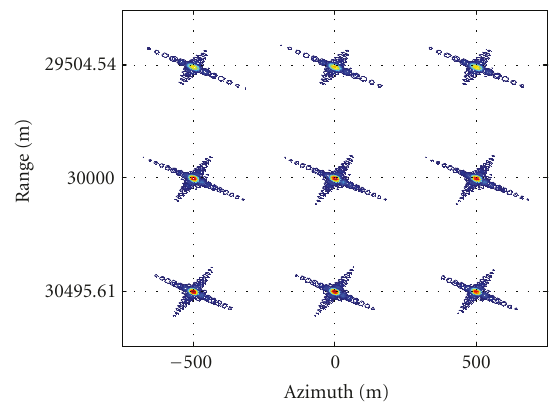
Figure 5: Contour plot of targets (squint angle ϕ = 60 ◦ ), where the image of each target has been zoomed and then pasted back into original figure according to its